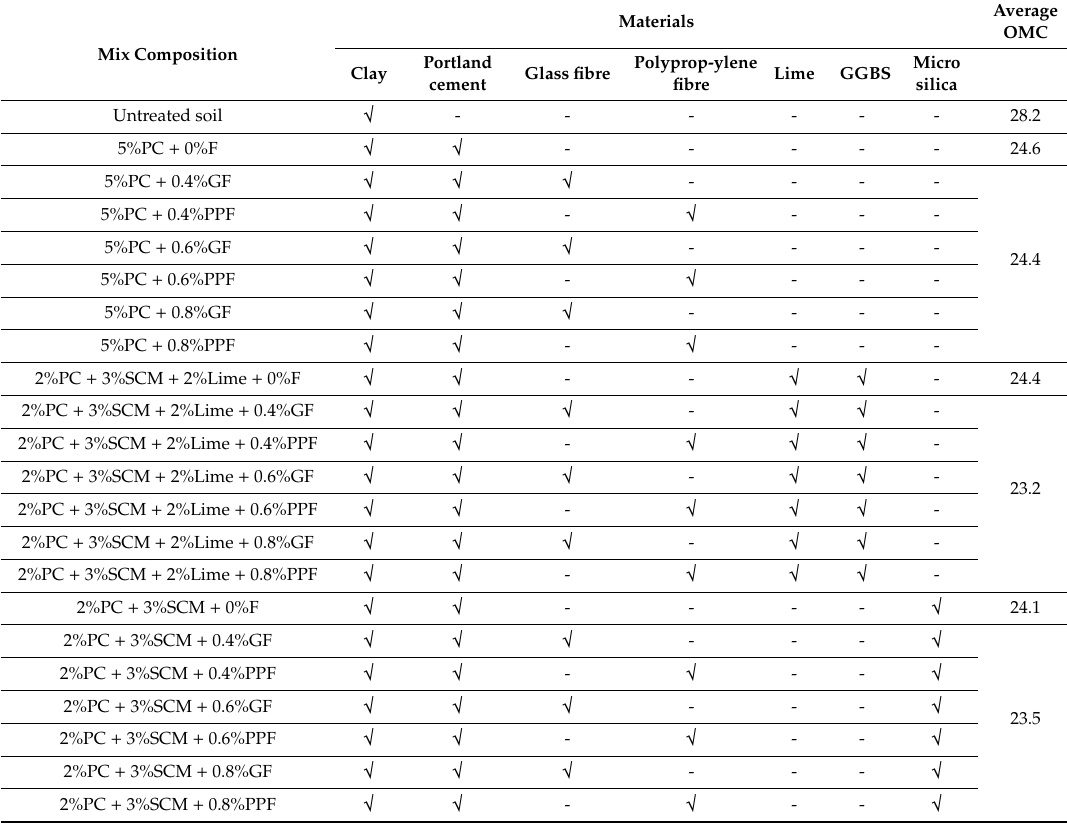
Table 3. Mix proportion and